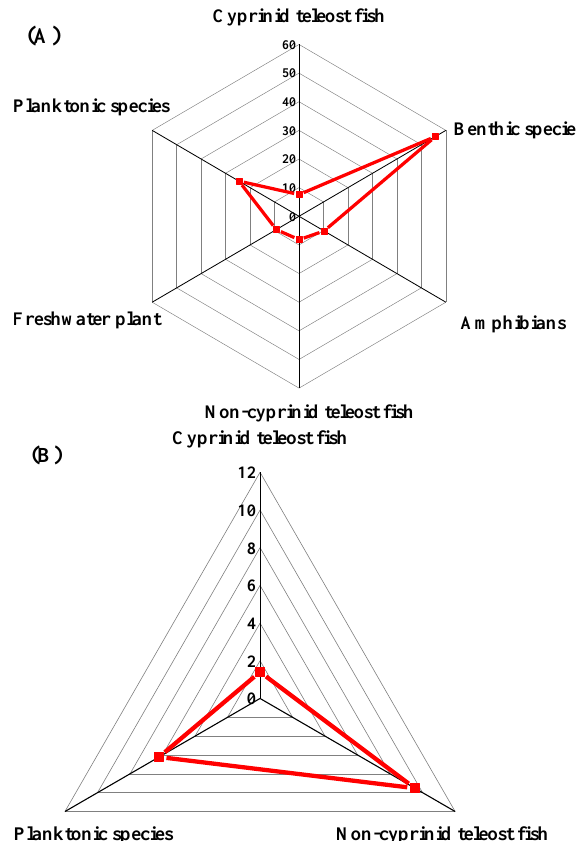
Figure 1. The geometric mean of ( A ) the SMAVs and ( B ) the SMCVs of silver to various taxonomic groups of freshwater aquatic organisms ( concentrations in μg/L ).